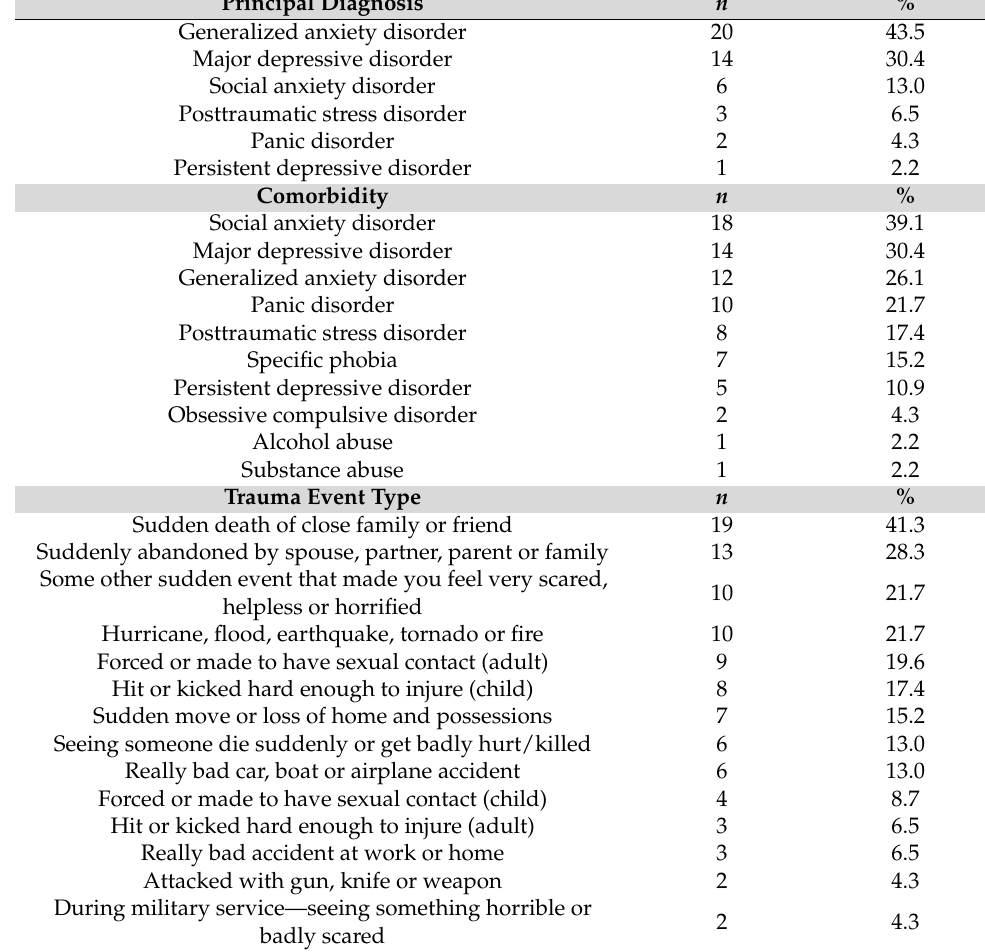
Table 1. Distribution of principal diagnosis and comorbidity; trauma event type based on Trauma History